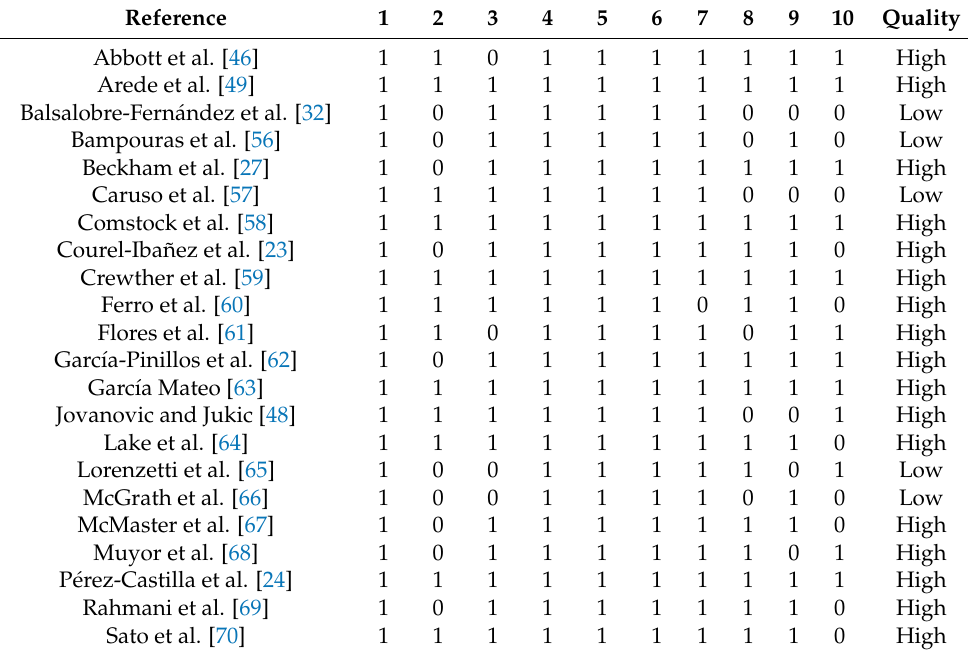
Table 2. Methodological assessment of the included